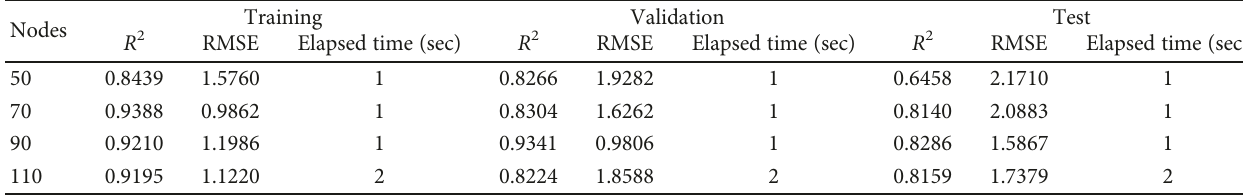
Table 6: Performance of ANN models for peroxide value